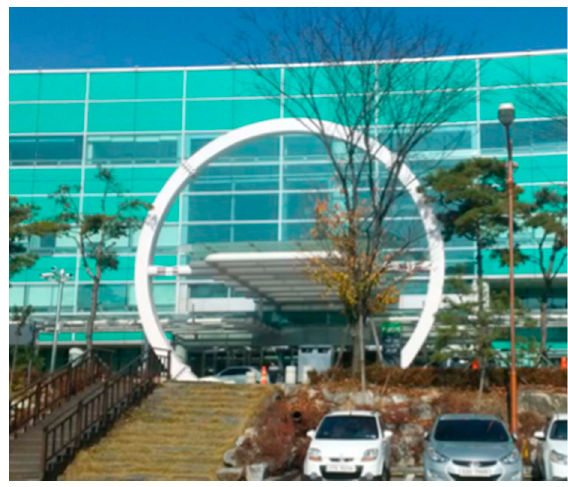
Figure 1. An example of a horseshoe circular arch as an entrance portal to a hospital at Wonkwang University in Iksan-si, Jeollabuk-do, Korea (Photo by B. K. Lee).